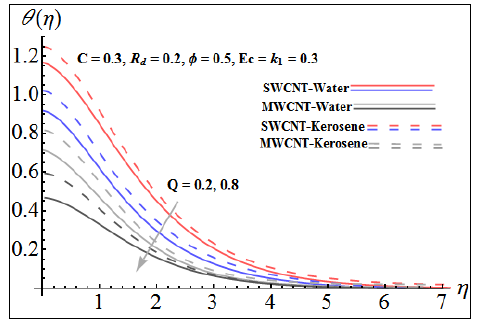
Figure 6. Behavior of θ ( η ) for increased values of C .